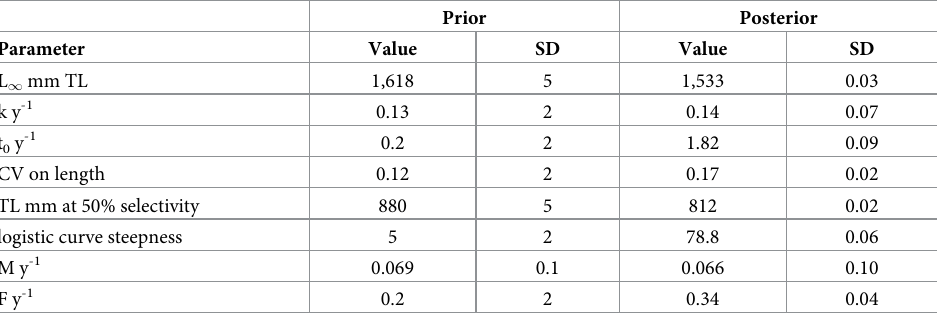
Table 1. Log-normal prior and posterior means and standard deviations for von Bertalanffy growth function, logistic selectivity, and instantaneous natural and fishing mortality variables. The model handles the variables in log space; standard deviation of each parameter is given in log